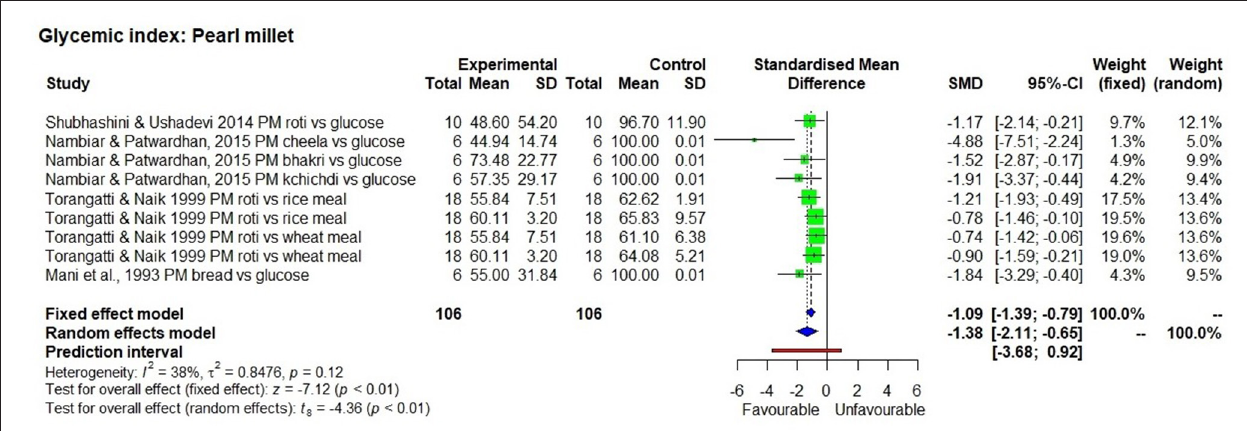
FIGURE 2 | The Glycaemic Index of a pearl millet diet compared to control samples. Abbreviations given in Figures 2–8: PM, Pearl millet; FM, Finger millet; DFM, Decorticated finger millet; ER, Expanded rice; WFM, Whole finger millet; GFM, Germinated finger millet; A vs. B, After vs. Before; SMY, Soya milk yoghurt;